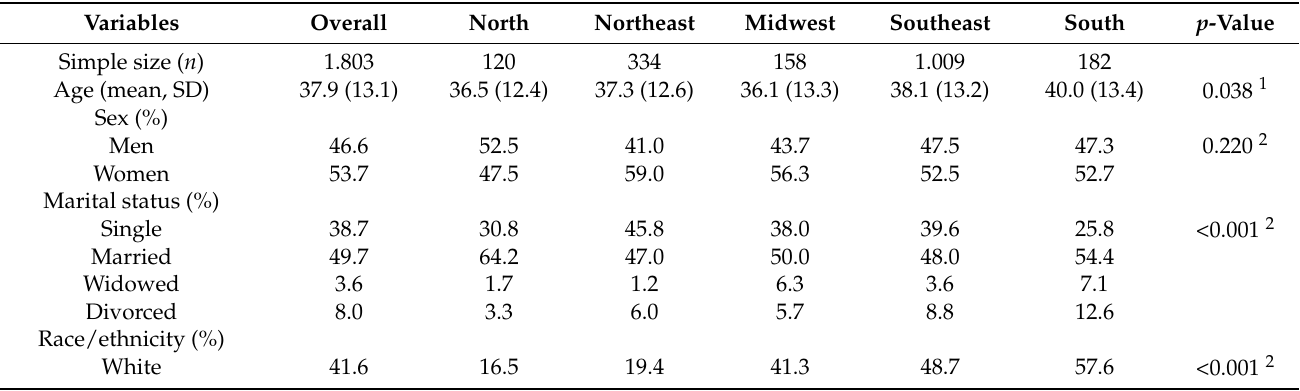
Table 1. Sociodemographic characteristics, physical activity and sitting time of